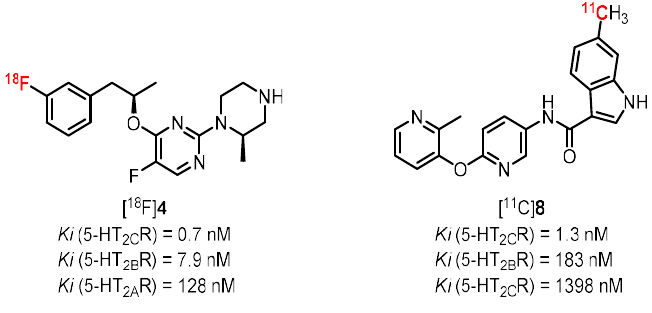
Figure 5. 5-HT 2C R selective radioligands.